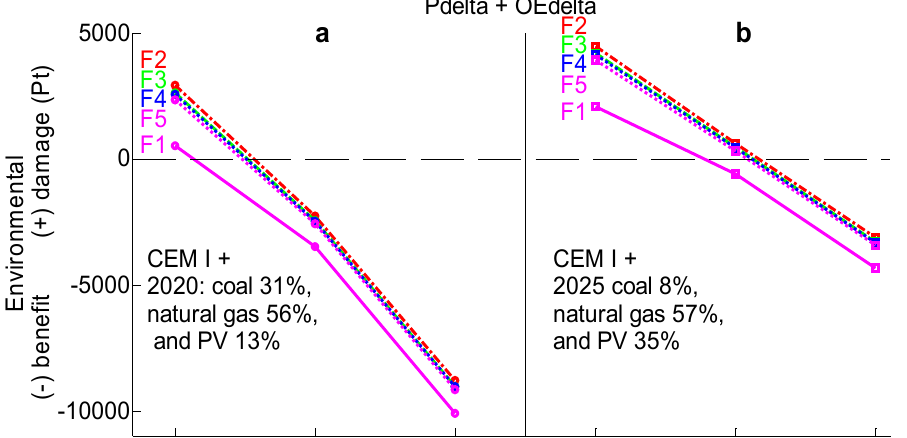
Figure 6. Group F sculptured tiles. Operational energy (OE) stage: environmental benefit of 2020 and 2025 OEdelta of F1–F5. Evaluation was performed with ReCiPe2016 endpoint single-score method using individualist/average (I/A), hierarchist/average (H/A), and egalitarian/average (E/A)